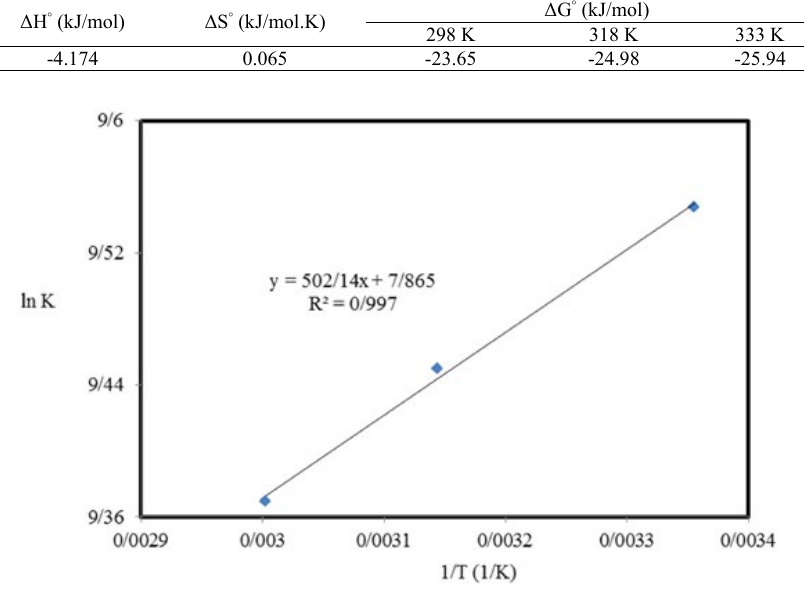
Fig. 8. (a) Plot of log K versus 1/T for sorption of MB onto Fe